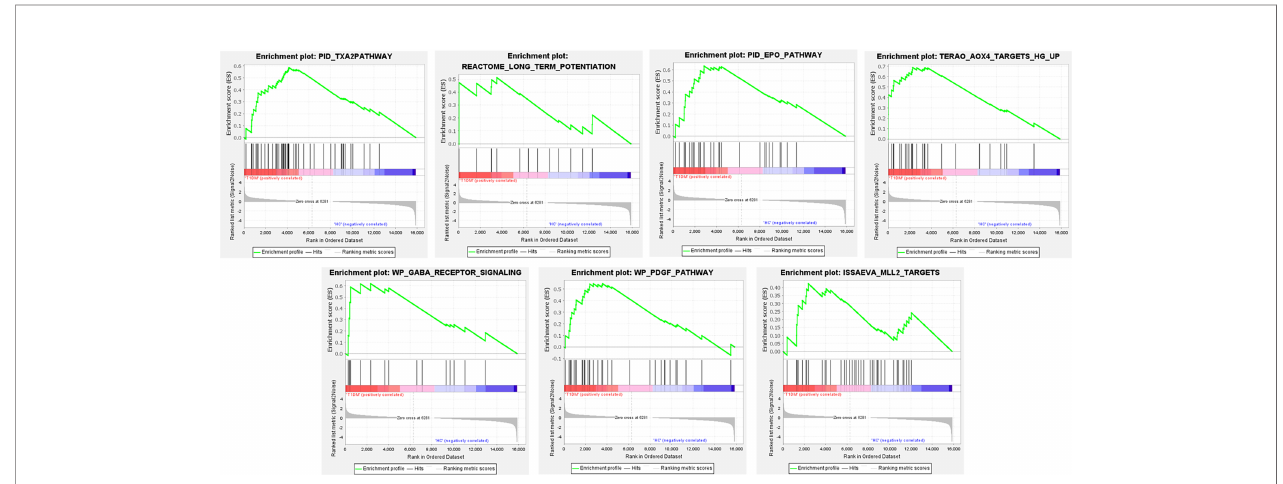
FIGURE 2 | The whole gene expression value of T1DM ketosis or ketoacidosis and control samples analyzed by GSEA software. The top seven gene sets were enriched with criterion of NES>2.5, FDR < 0.25, and p -value < 0.01.